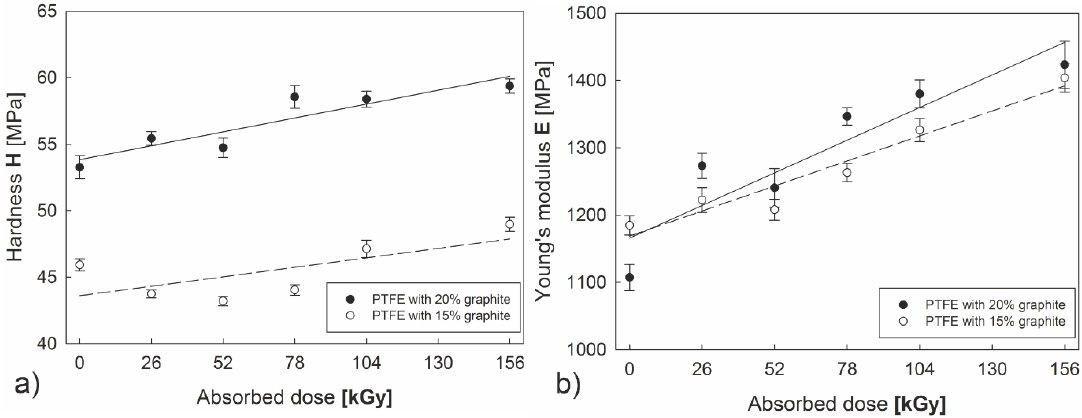
Figure 6. Impact of electron beam irradiation on changes in microhardness H ( a ) and modulus of elasticity E ( b ) of PTFE-graphite composites.